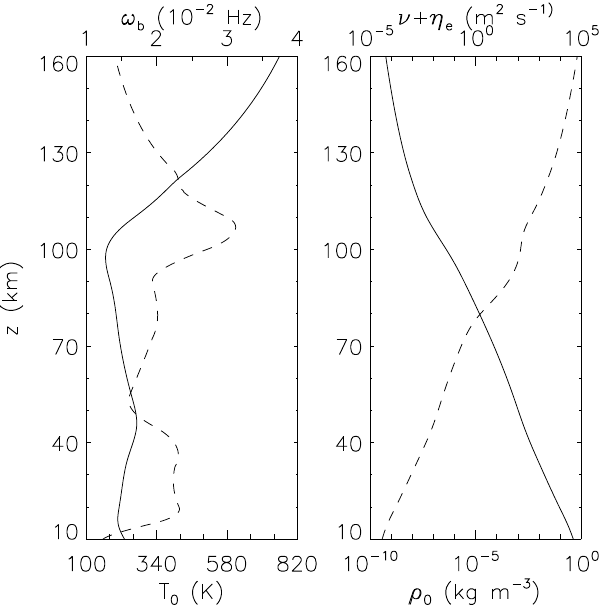
Fig. 1. Vertical profiles of background temperature, buoyancy fre- quency, density and total momentum diffusivity. The solid lines with scale on the lower horizontal axis denote the background temperature and density in left and right panels, respectively. The dashed lines with scale on the upper horizontal axis denote the buoyancy frequency and total momentum diffusivity in left and right panels,